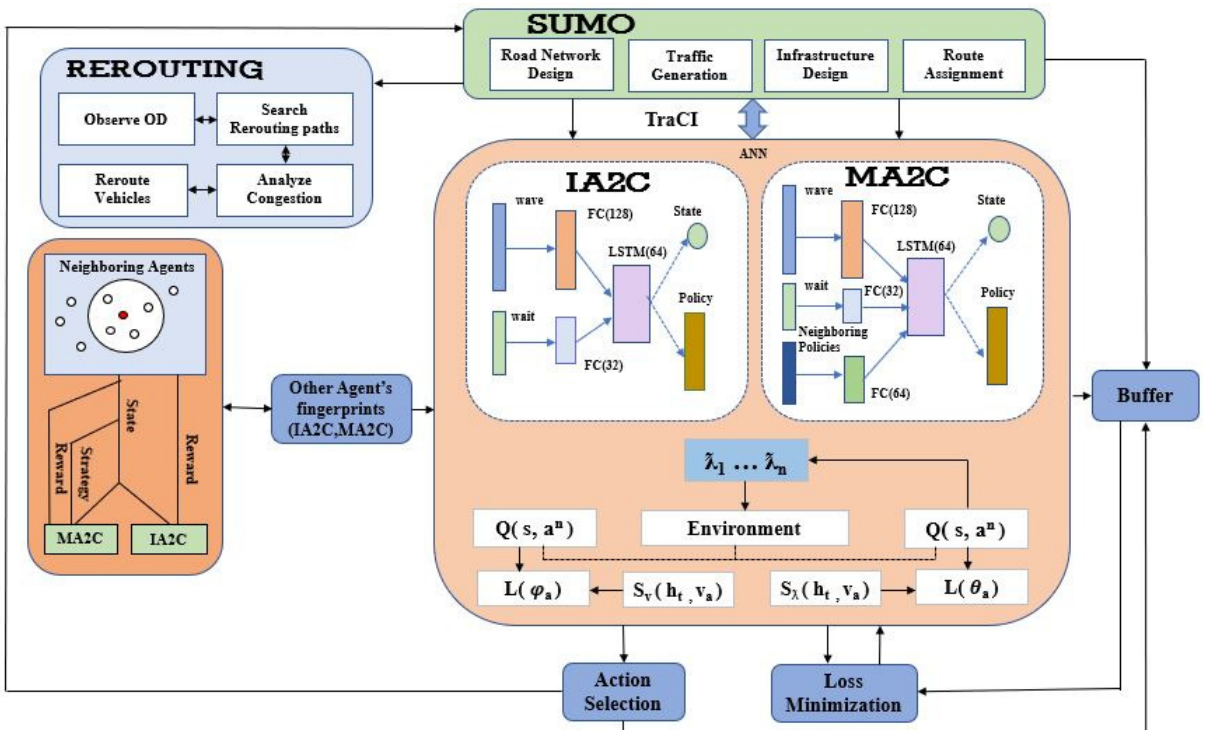
Figure 1. Proposed Approach: Traffic Flow Management using Independent Advantage Actor-Critic (IA2C), Multi-Agent Advantage Actor-Critic (MA2C) and Routing of